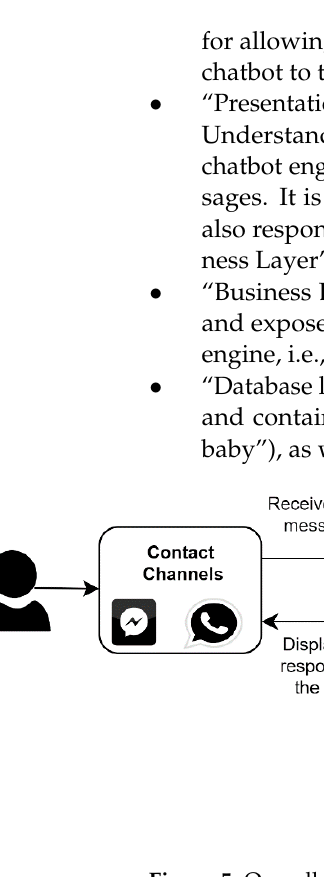
Figure 5. Overall chatbot architecture.